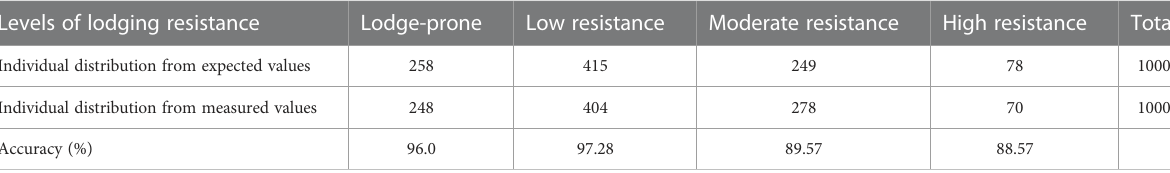
TABLE 3 Comparing of the lodging resistance levels of plants by measured and inferred